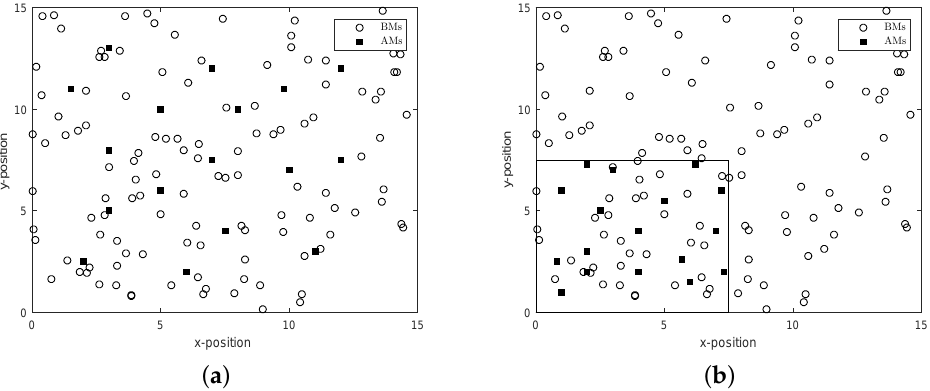
Figure 1. Distribution of anchor machines (AMs). ( a ) AMs uniformly distributed over the whole area; ( b ) AMs distributed uniformly in the lower left